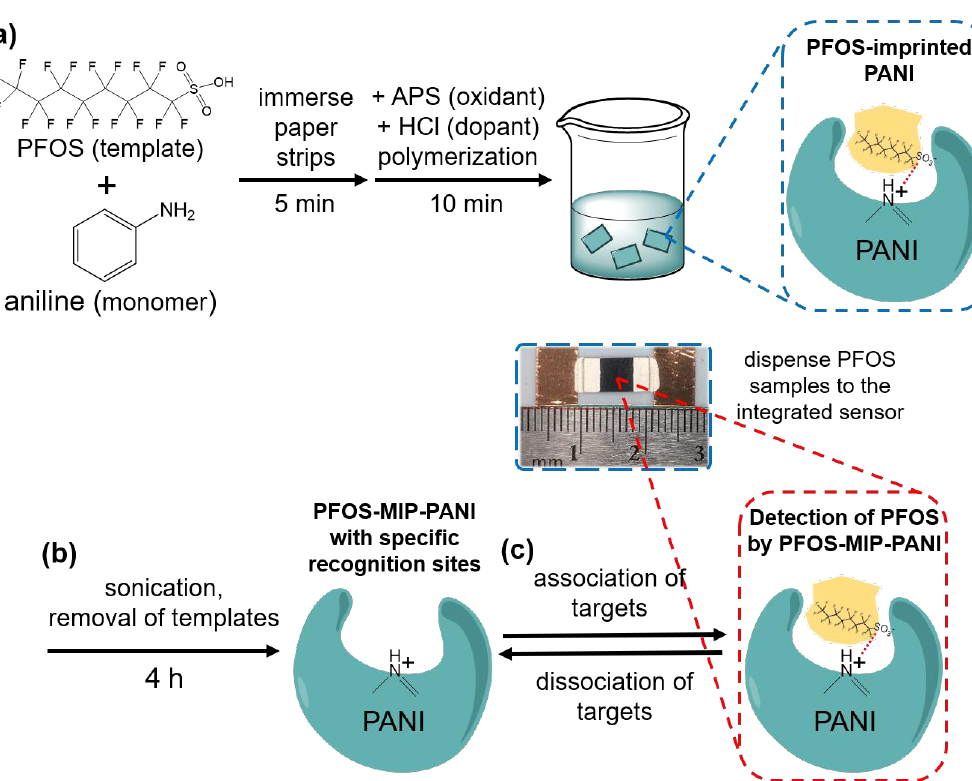
Figure 1. The schematic diagram of the synthesis of PFOS-MIP-PANI and the molecular imprinting process. ( a ) PFOS, as the template, was first mixed with aniline monomers in HCl aqueous solution, followed by immersing paper strips for the thorough absorption of the monomers on the surface. The polymerization was initiated by adding the oxidant, and the PFOS-imprinted polyaniline (PANI) was synthesized. ( b ) The PFOS templates were removed by sonication for 4 h in a mixed solution of acetic acid and methanol at a v / v ratio of 1:6, leaving cavities of specific recognition sites. ( c ) PFOS samples were then dispensed to the surface of the integrated paper sensor, and the PFOS-MIP-PANI was then able to detect PFOS by the molecularly imprinted structures. PFOS targets and PFOS-MIP-PANI performed an equilibrium system of association and dissociation.